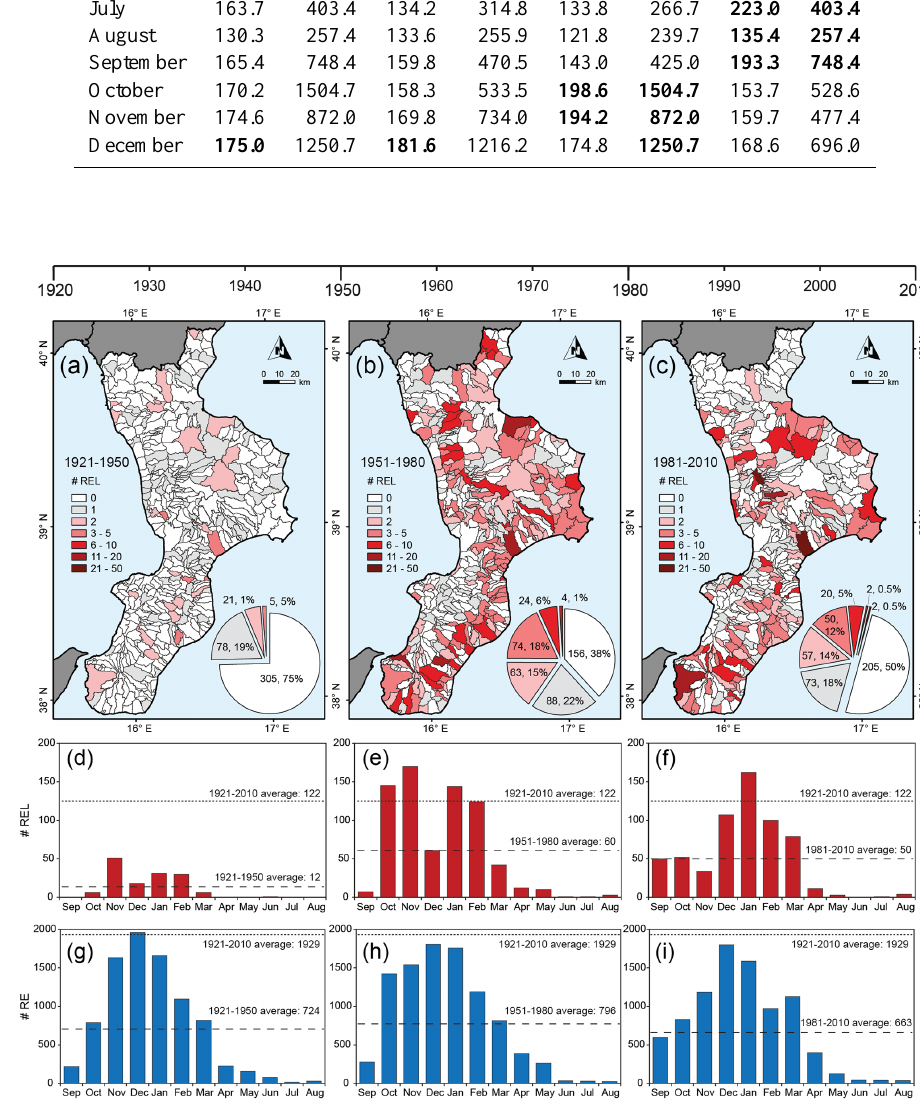
Figure 6. Maps show the number of rainfall events with landslides (#REL) in each municipality in Calabria in the three 30-year periods, (a) 1921–1950, (b) 1951–1980, and (c) 1981–2010. Pie charts show number and percentage of municipalities in each class. Middle: Red bars in (d) , (e) and (f) show number of REL per month in the three 30-year periods. Bottom: Blue bars in (g) , (h) and (k) show number of RE per month in the three 30-year